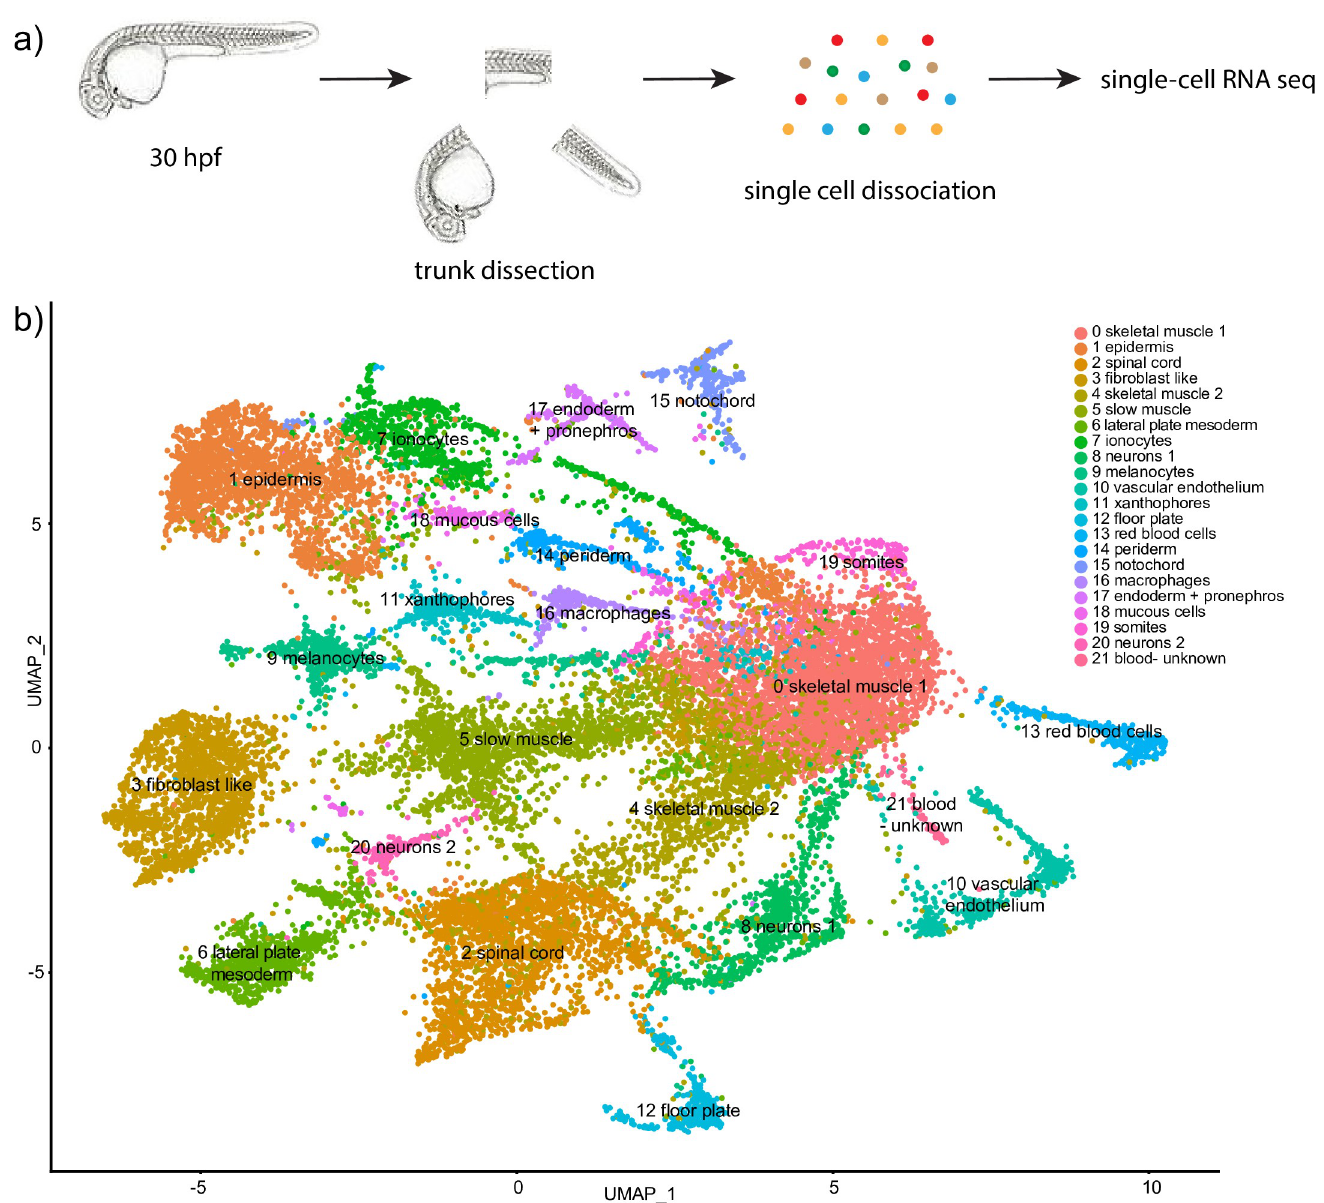
Fig 1. Single-cell RNA-seq analysis of trunk region in 30 hpf wild type embryos. (a) A diagram showing trunk dissection and single cell dissociation followed by single-cell RNA-seq analysis. (b) UMAP plot of 20,279 cells identified a total of 22 different cell clusters.